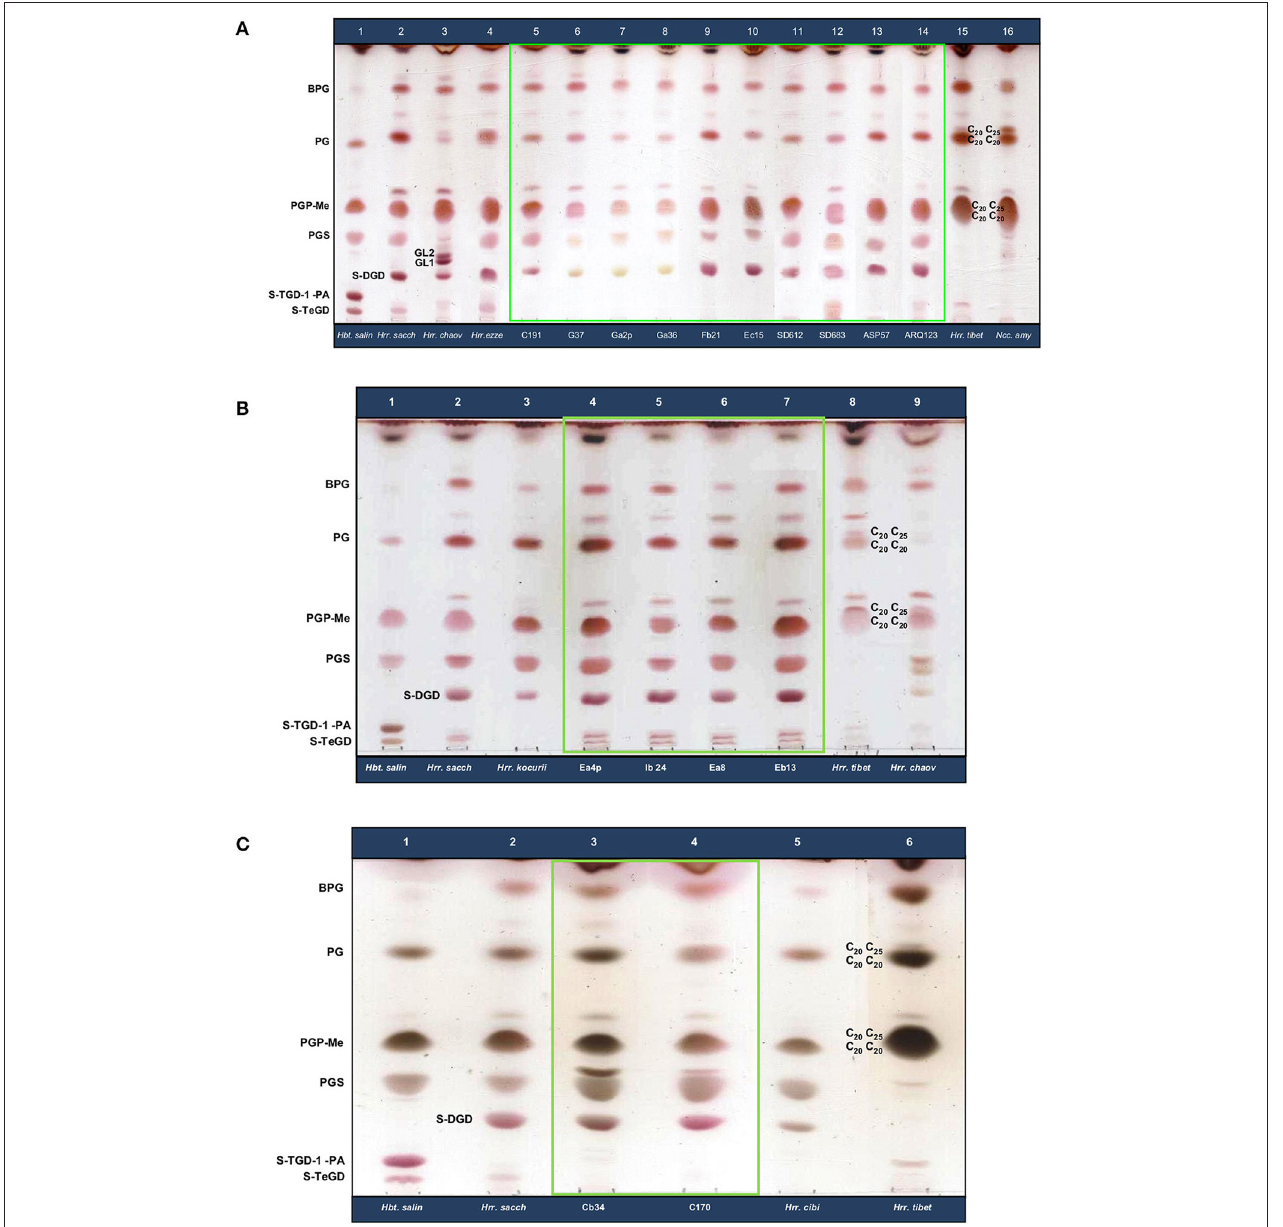
FIGURE 4 | HPTLC stained with 5% (v/v) sulfuric acid showing the polar lipid profiles for Halorubrum strains belonging to group 1 and related taxa (A) , to group 2 and related taxa (B), and to group 3 and related taxa (C) . Hbt. salin , Halobacterium salinarum DSM 3754 T ; Hrr. sacch , Halorubrum saccharovorum DSM 1137 T ; Hrr. chaov , Halorubrum chaoviator Halo-G* T ; Hrr. ezze , Halorubrum ezzemoulense DSM 17463 T ; Hrr. tibet , Halorubrum tibetense JCM 11889 T ; Ncc. amy , Natronococcus amylolyticus DSM 10524 T ; Hrr. kocurii , Halorubrum kocurii CECT 7322 T ; Hrr. cibi , Halorubrum cibi JCM 15757 T . BPG, biphosphatidylglycerol; PG, phosphatidylglycerol; PGP-Me, phosphatidylglycerolphosphate methyl ester; PGS, phosphatidylglycerolsulfate; GL, unidentified glycolipid; S-DGD, sulfated mannosyl glucosyl diether; S-TGD-1-PA, sulfated galactosyl mannosy glucosyl dietherphosphatidic acid; S-TeGD, sulfated tetraglycosyl